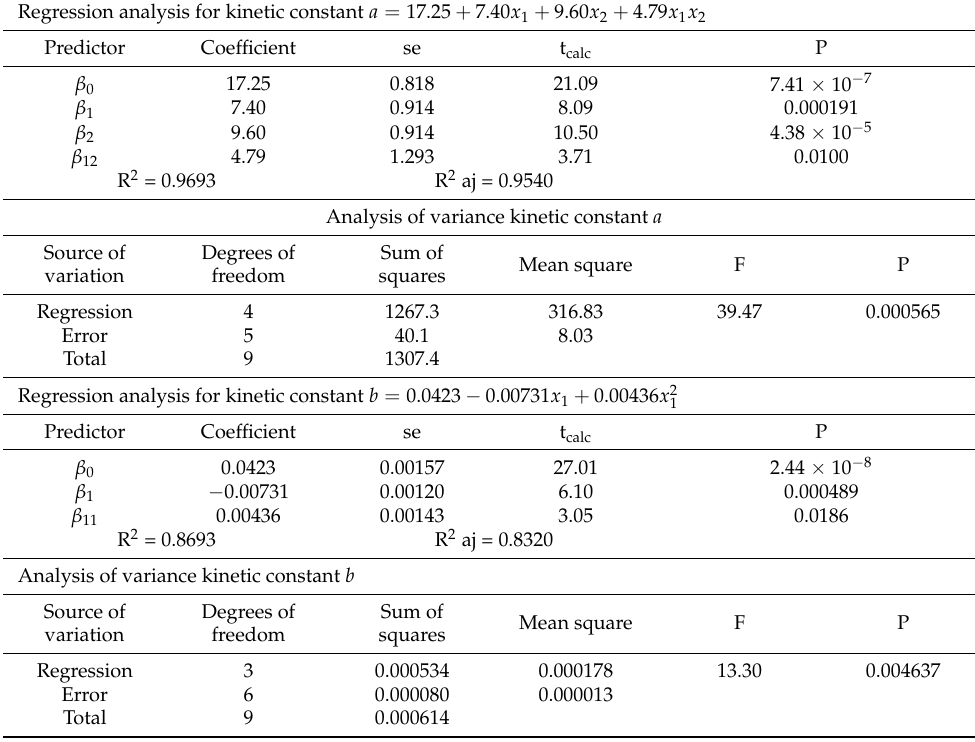
Table 5. Regression and variance analysis for RSM models for kinetic constants a and b for the enzymatic hydrolysis of milk proteins with